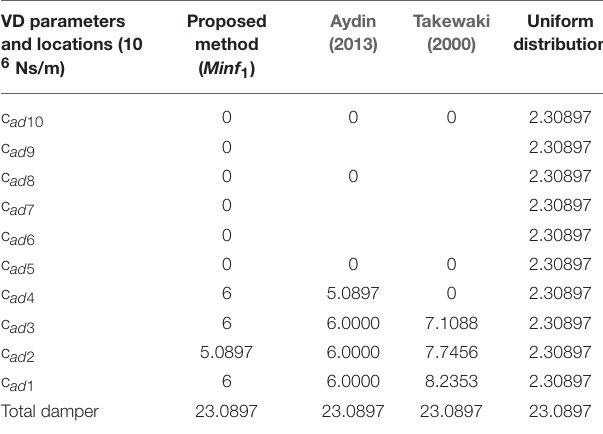
TABLE 4 | Properties of VDs parameters and their locations to the floors for 10 story shear frame. VD parameters and locations